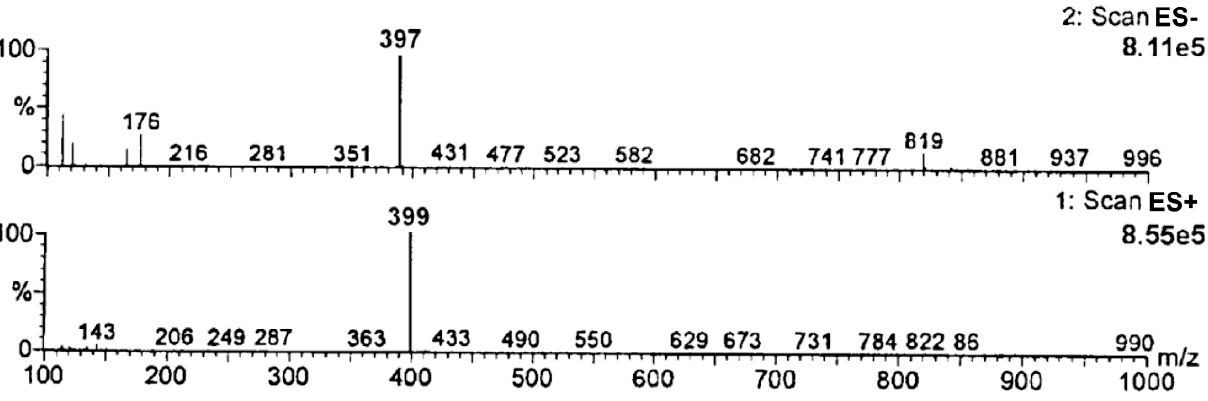
Table 2. The m/z values of [M − H] − [M + H] + for DKP and RAM. Compound